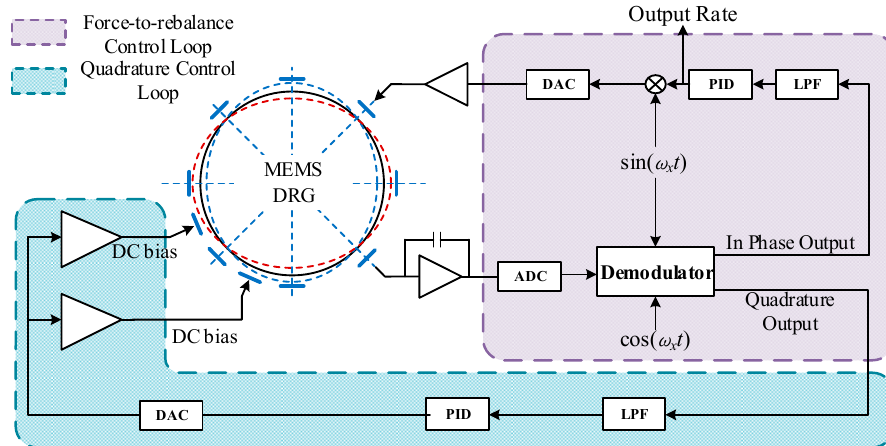
Figure 7. Schematic diagram of force-to-rebalance control loop and quadrature control loop.